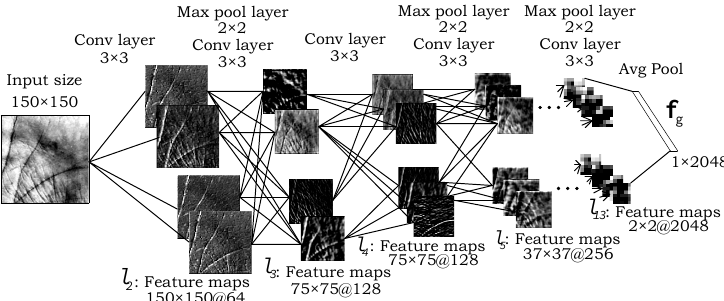
Figure 4. Detailed illustration of the global processing path from Figure 3a, along with the feature maps extracted at different levels of the model. A fully convolutional VGG-16 backbone is used to extract a global palmprint representation f g from the input image.